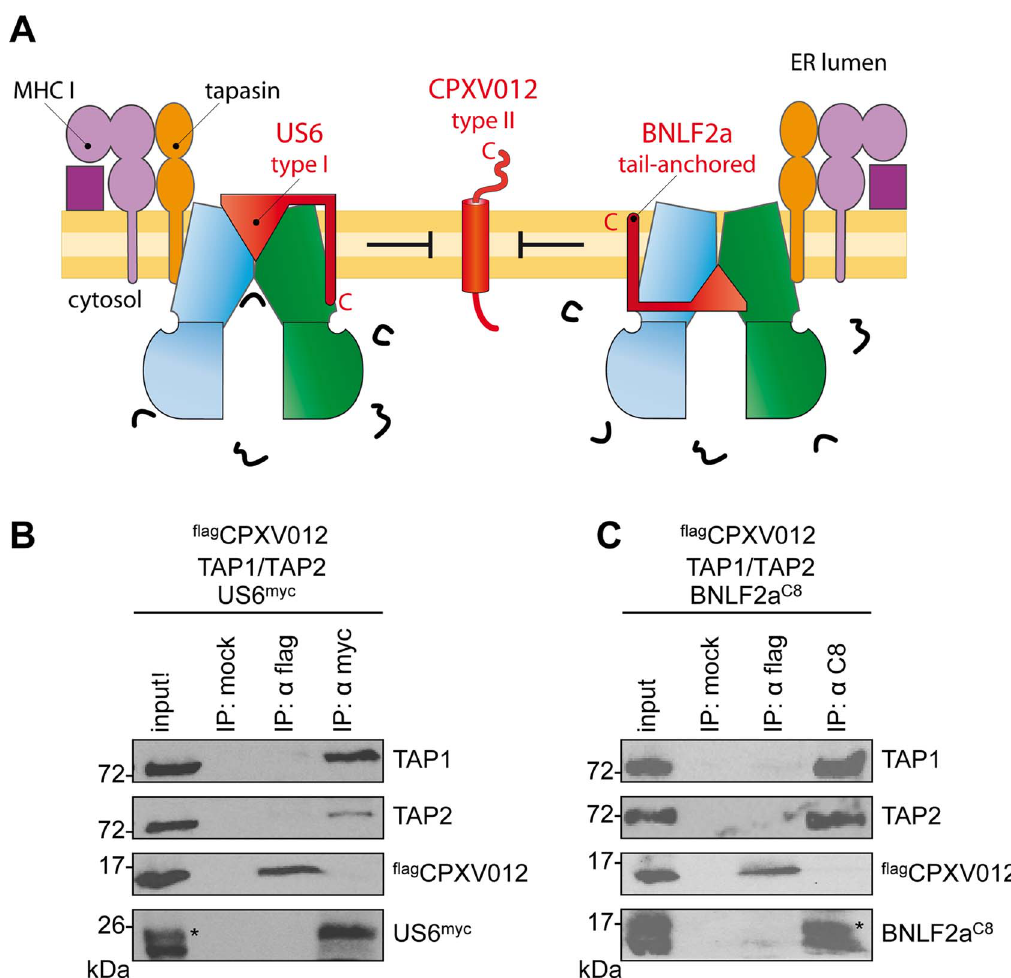
Fig. 4. HCMV-US6 and EBV-BNLF2a prevent the formation of CPXV012 N TAP complexes. (A) Schematic presentation of the MHC I peptide- loading complex and the viral immune evasin US6 (type I membrane protein), BNLF2a (tail-anchored), and CPXV012 (type II). (B, C) flag CPXV012, TAP1, and TAP2 were coexpressed with either US6 myc (B) or BNLF2a C8 (C) in Sf 9 cells. Proteins were affinity-purified with myc-, flag-, or C8-specific antibodies (IP). The HC10-antibody was used as negative control (mock). Samples were analyzed by immunoblotting with the corresponding antibodies. An aliquot (1/20) of the crude membrane input is shown. *, glycosylated protein.